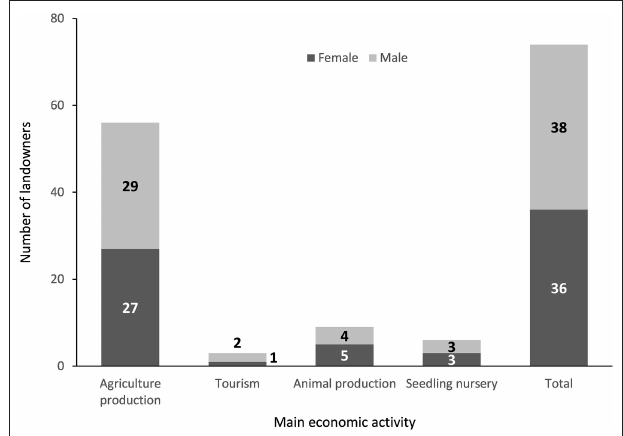
FIGURE 4 | Number of local landowners at the workshop divided by main economic activity and